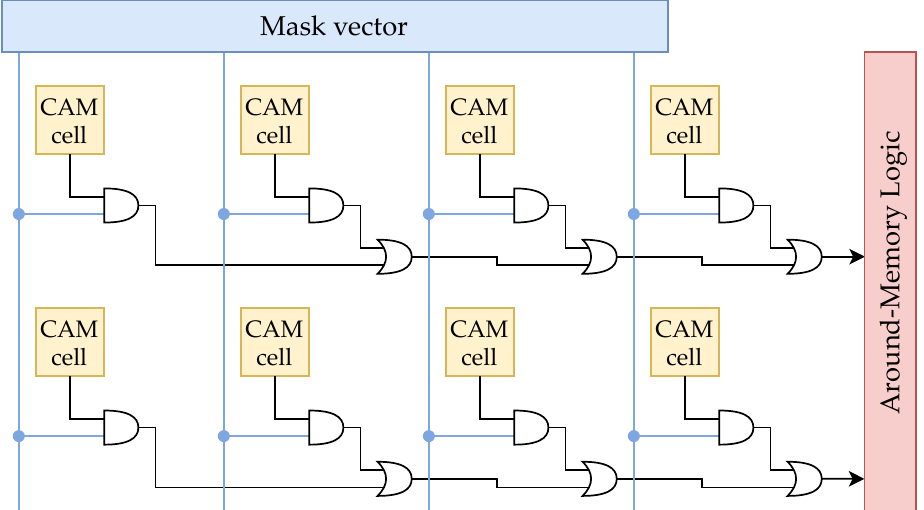
Figure 6. The LiM array. It consists of CAM cells to which the AND logic function capability is added; the results of the AND operations are OR-ed on the rows and provided to the Near-Memory